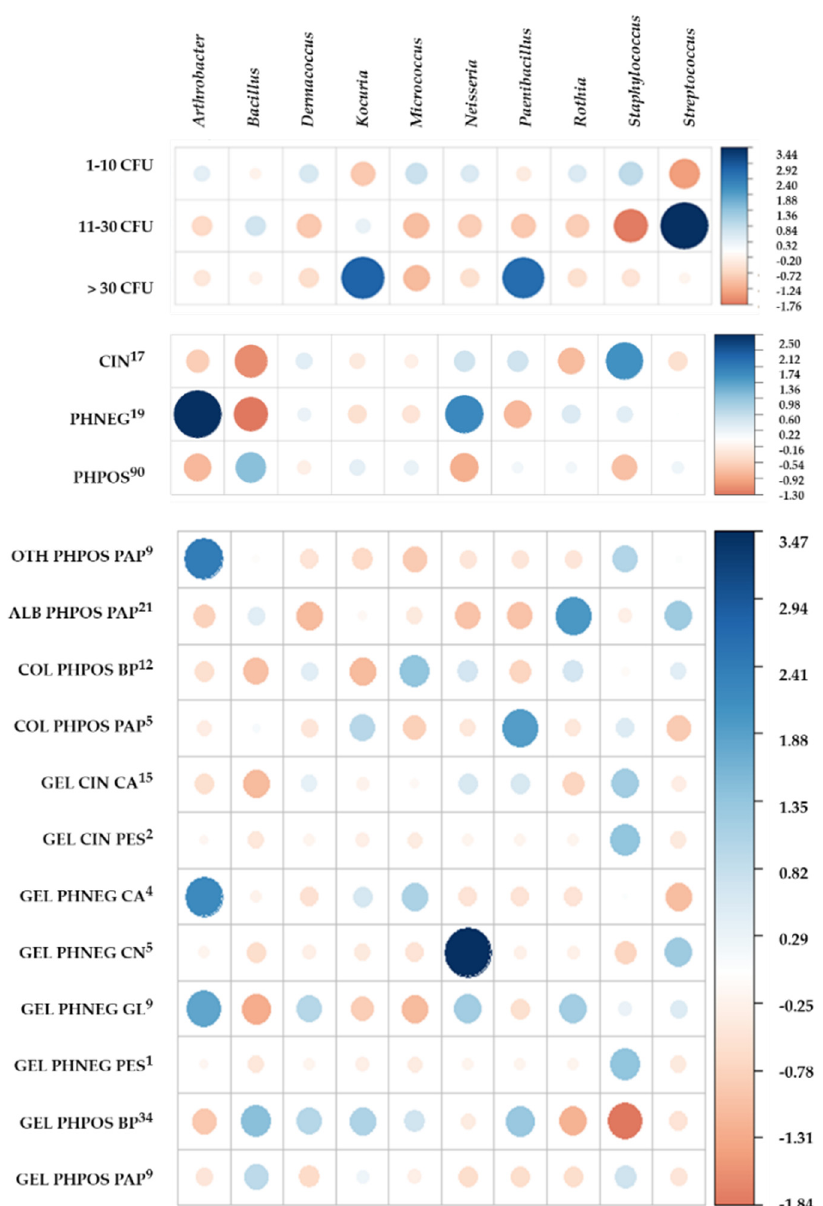
Figure 3. The standardized Pearson residuals for positive (blue) and negative (red) associations of the ten most frequent bacterial genera with analysed factors. These associations are between the bacterial genus and the number of its CFU isolated from a sample (regarding single species), its isolation from single kinds of material (CIN, PHNEG, PHPOS) and the combination of the sample type and the material of the light-sensitive layer and carrier. The size of the circle is proportional to the degree of cell contribution. The upper index indicates the number of analysed samples. Legend: